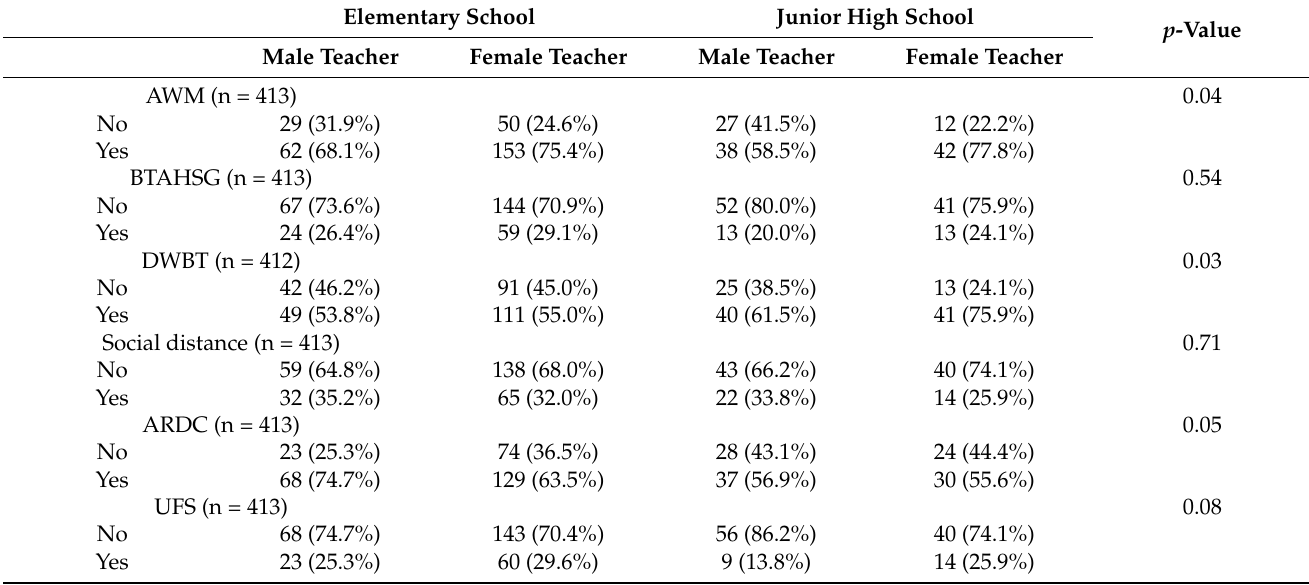
Table 5. Stress causes for teachers associated with COVID-19 infection